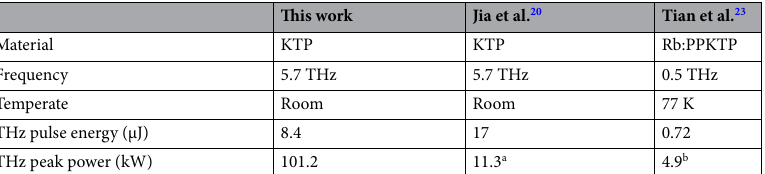
This work Jia et al. 20 Tian et al. 23